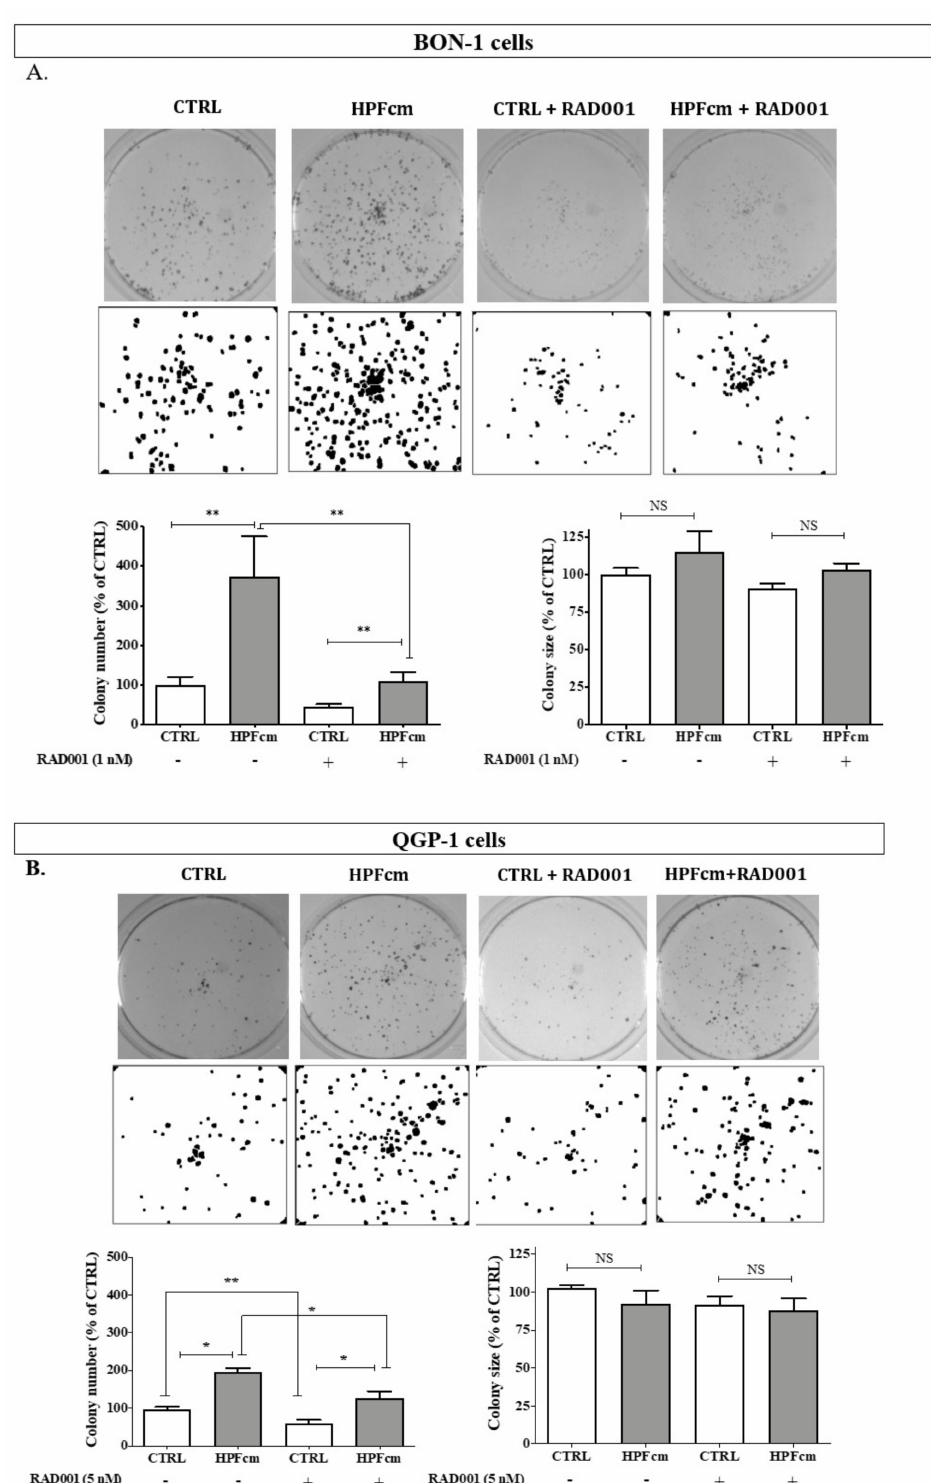
Figure 4. Colony-formation assays of PNEN cells. Incubation with HPFcm resulted in higher numbers of BON-1 colonies, which was reversed by adding RAD001 (1 nM), while no effect from either HPFcm or RAD001 was observed on the size of the colonies (( A ) and pictures in the upper panel). Similarly, the number of QGP-1 colonies increased in the presence of HPFcm but the effect of RAD001 (5 nM) was less pronounced than in BON-1 (( B ) and pictures from the lower panel). Again, the size of the colonies was not affected by either RAD001 or HPFcm. ** p < 0.01; * p < 0.05; NS: not